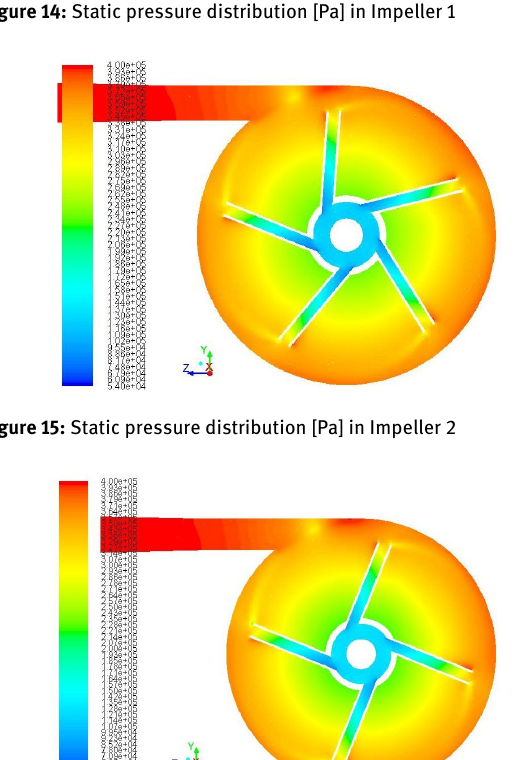
Figure 14: Static pressure distribution [Pa] in Impeller 1